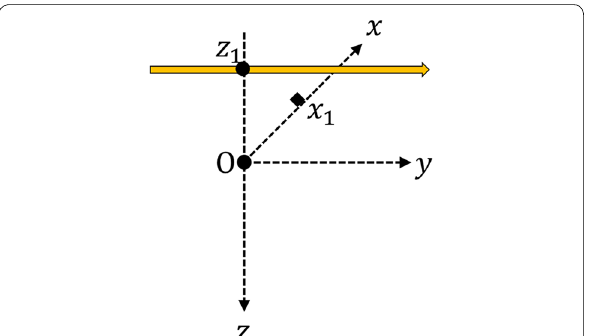
, Fig. 1 Coordinate system used in this study. The symbol of “O”